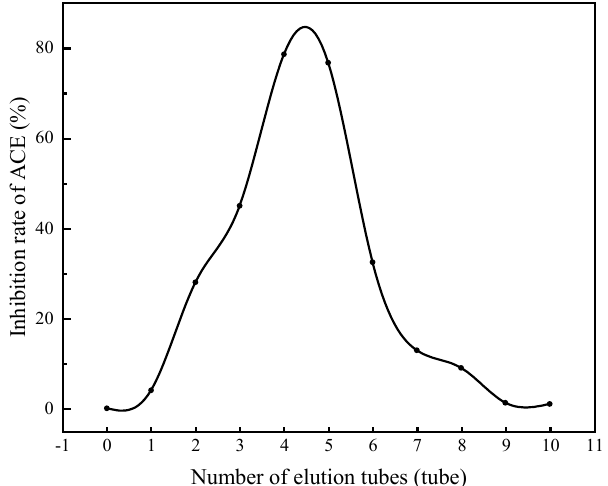
Figure 10. ACE inhibitory activity of different components after separation using SephadexG-100. The purified active peptides were separated by SephadexG-100, and the activity changes in split-peak collection samples were measured, collecting each tube every 5 min.